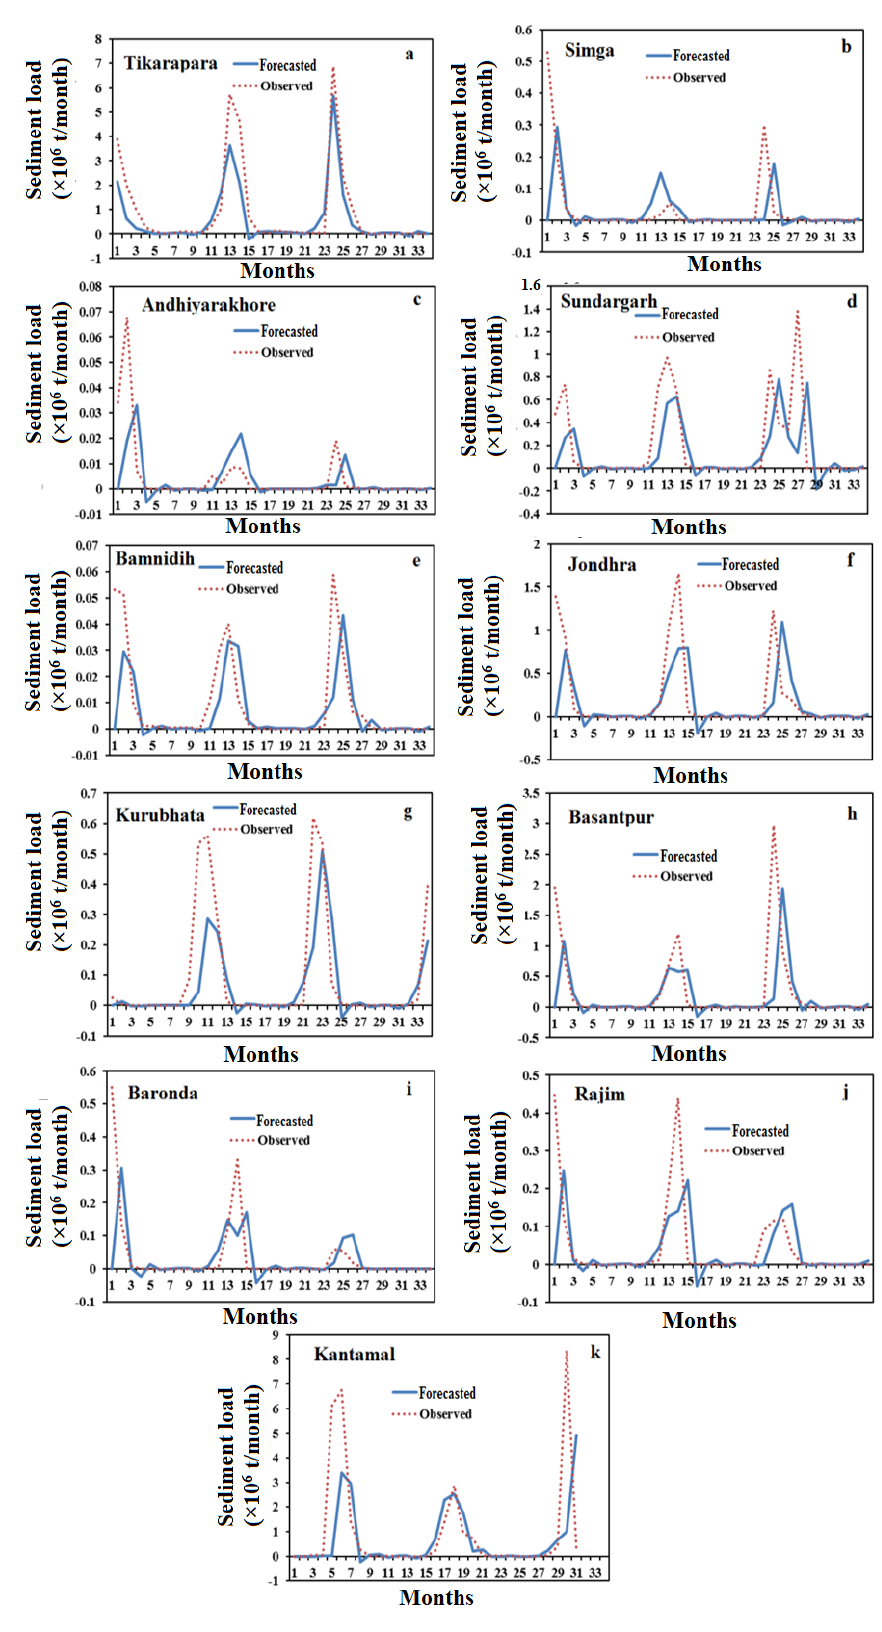
Figure 9. Comparison of the actual and forecasted SL during the testing phase of the AR forecasting model (a-k) .